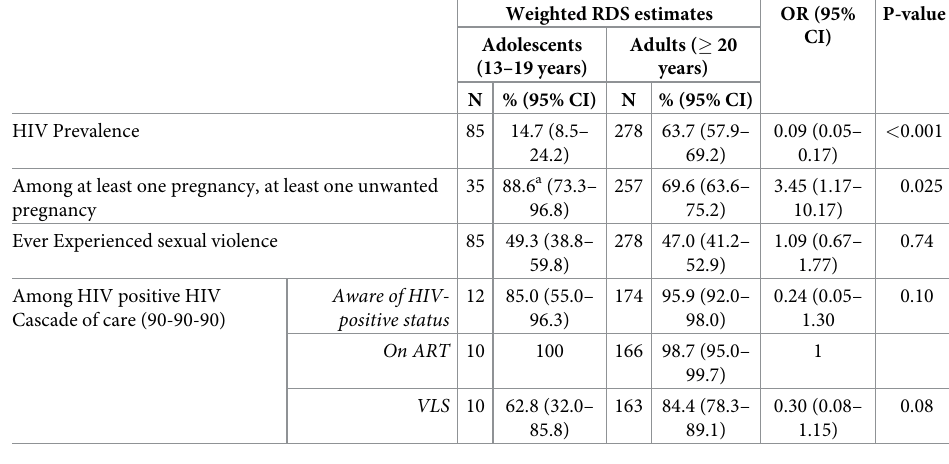
Table 4. Logistic regression for adolescents (13–19 years) compared to adults ( � 20 years) on some key